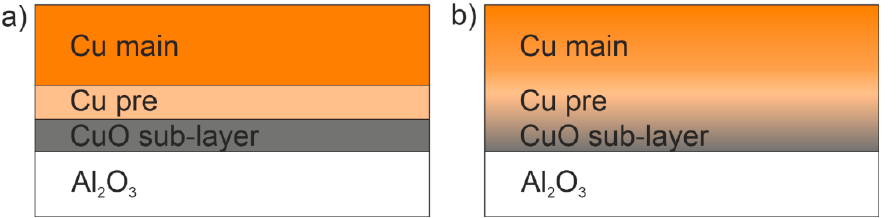
Figure 11. ( a ) Structure of a multi-layer metallizing film; ( b ) Structure of a gradient metallizing